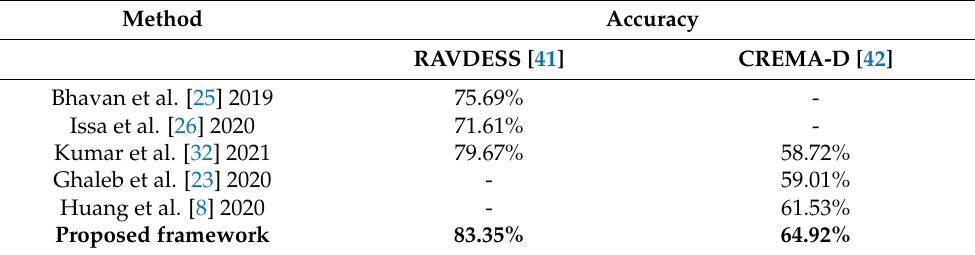
Table 3. Comparative experimental results of the proposed emotion recognition framework with various state-of-the-art